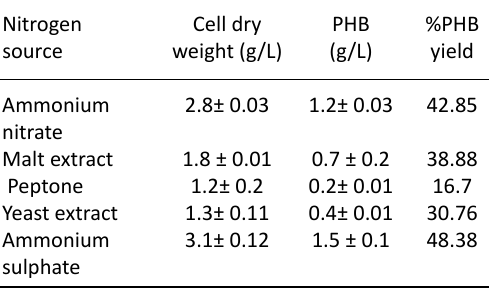
Table 9. Effect of different nitrogen source on PHB